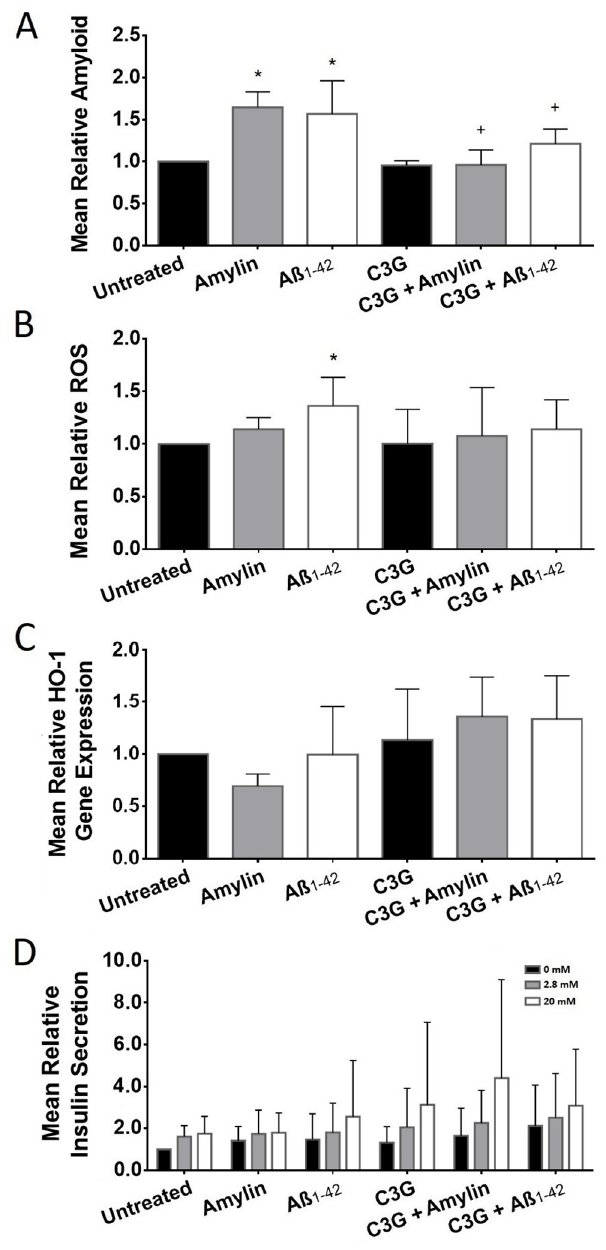
Fig 3. Amyloid formation, ROS production, HO-1 gene expression, and insulin secretion in human islets treated with or without C3G and with or without amylin or A β 1-42 . (A) Mean relative amyloid formation in untreated and C3G-treated islets exposed to amylin or A β 1-42 ( � p < 0.001, untreated vs. amylin or A β 1-42 ; n = 5–6; + p < 0.01, amylin vs. C3G + amylin; + p < 0.05, A β 1-42 vs. C3G + A β 1-42 ; n = 5). (B) Mean relative ROS detected in untreated or C3G-treated islets exposed to amylin or A β 1-42 ( � p < 0.05, untreated vs. A β 1-42 ; n = 5–6). (C) Mean relative HO-1 gene expression in untreated or C3G-treated human islets (n = 3). (D) Mean relative in vitro static glucose-stimulated insulin secretion of C3G-treated human islets exposed to amylin or A β 1-42 in low glucose (2.8mM, gray bar) and high glucose (20mM, white bar)-containing media. Black bar represents 0mM glucose-containing media (n = 5).